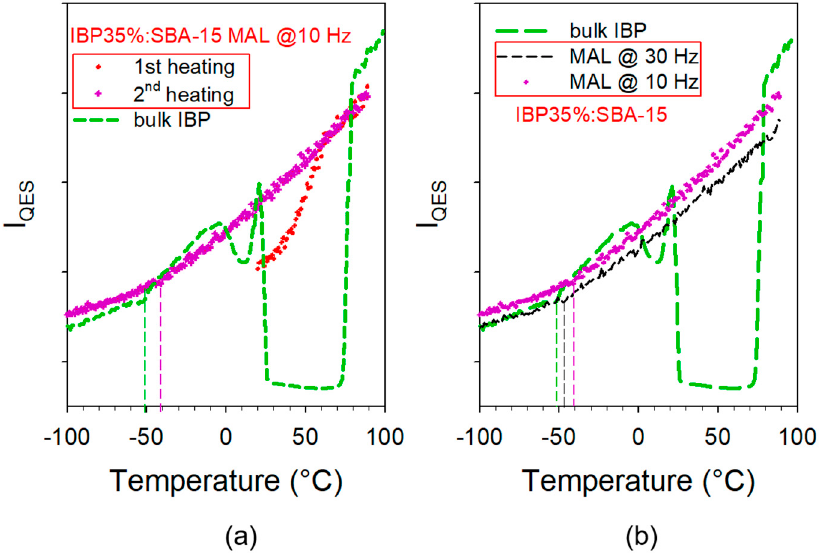
Figure 6. Temperature dependence of the quasielastic intensity (I QES ) of the composite (IBP35%:SBA-15) compared with that of bulk IBP; ( a ) I QES calculated in the first and second heating runs of the composite prepared by MAL at 10 Hz; ( b ) comparison between composites prepared by MAL at 10 Hz and 30 Hz .